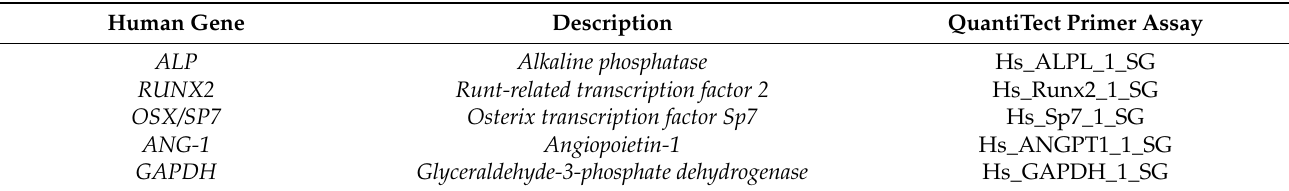
Table 3. List of the primer sequences of target genes used for